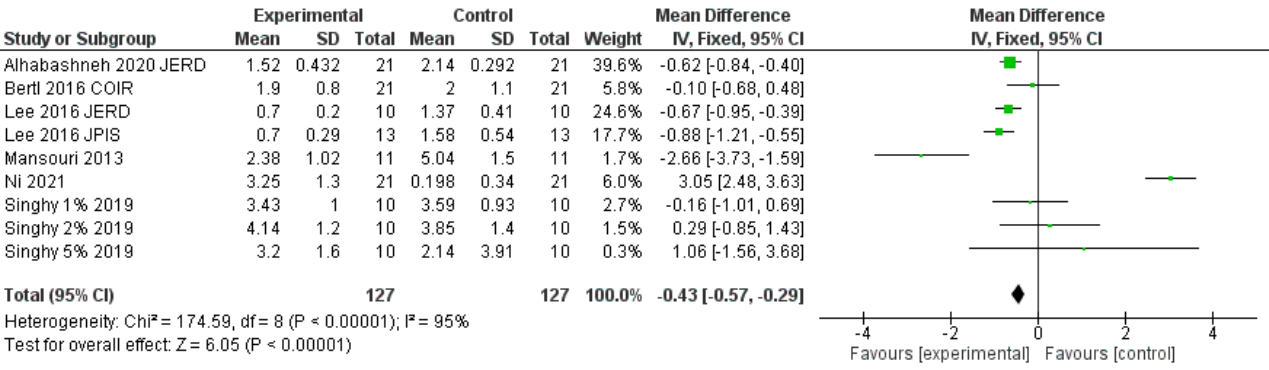
Figure 2. Forest plot reconstruction of interdental papilla deficiency with HA. Height values (mm) indicate a favourable result of HA injection.